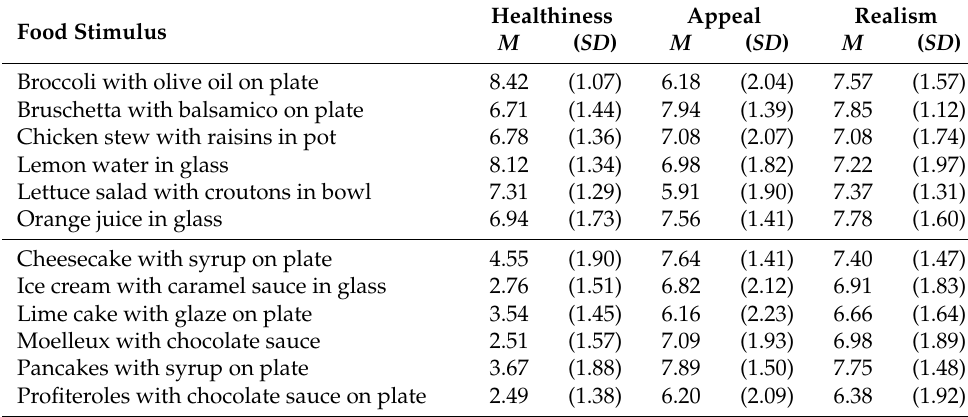
Table A2. Overview of pretest results for the food stimuli used in Study 2b. Food